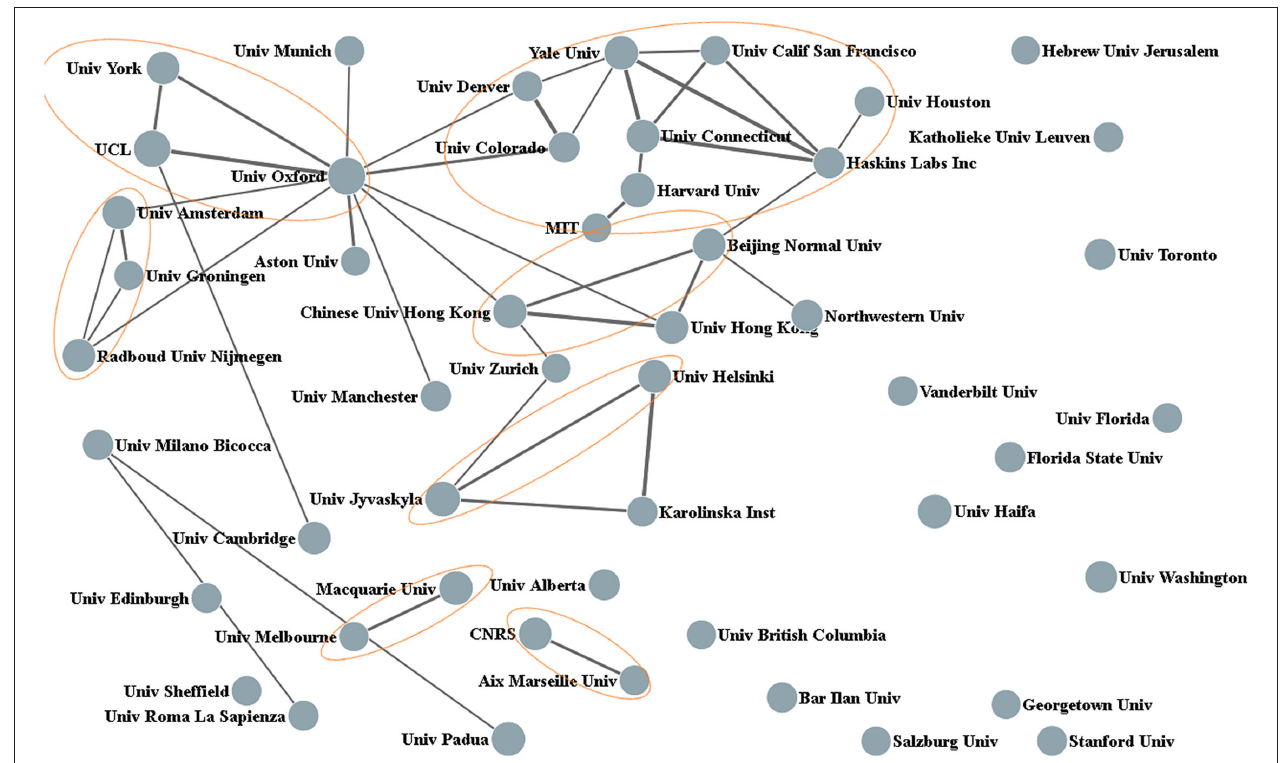
FIGURE 3 | Collaborative relationships among the top 50 most productive organizations.